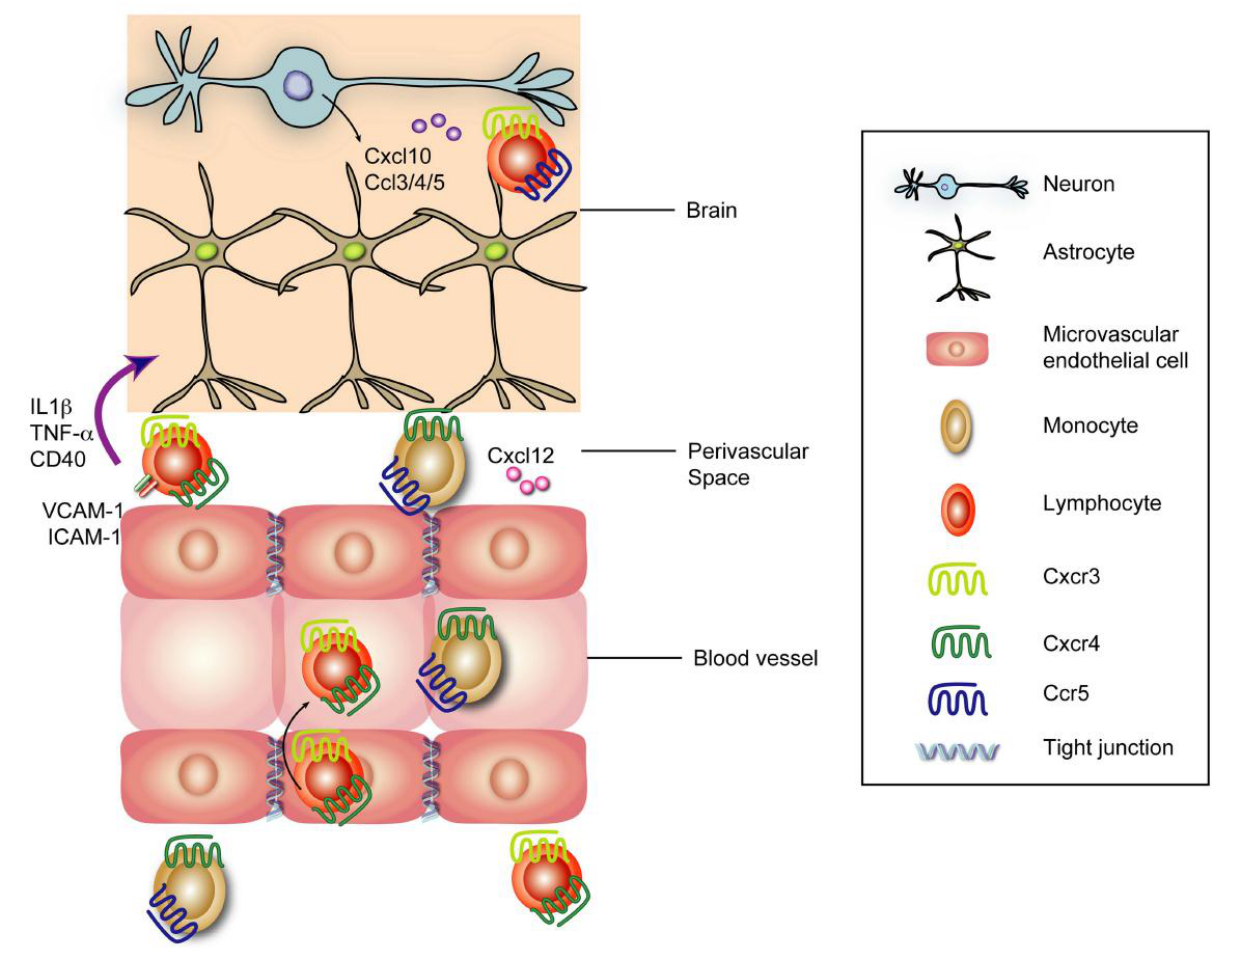
Figure 2. Leukocyte trafficking into the CNS after WNV. Upon WNV infection of neurons, virus-mediated upregulation of Cxcl10 recruits virus-specific CD8 + T cells via interactions with Cxcr3. Expression of Ccl3, Ccl4, and Ccl5 by other neuronal cells recruits Ccr5-expressing leukocytes. Monocytes and lymphocytes entering the perivascular spaces may be retained initially via Cxcr4 binding Cxcl12 [120]. Leukocyte egress from perivascular spaces requires IL-1β, TNF-  , and CD40 interactions, which